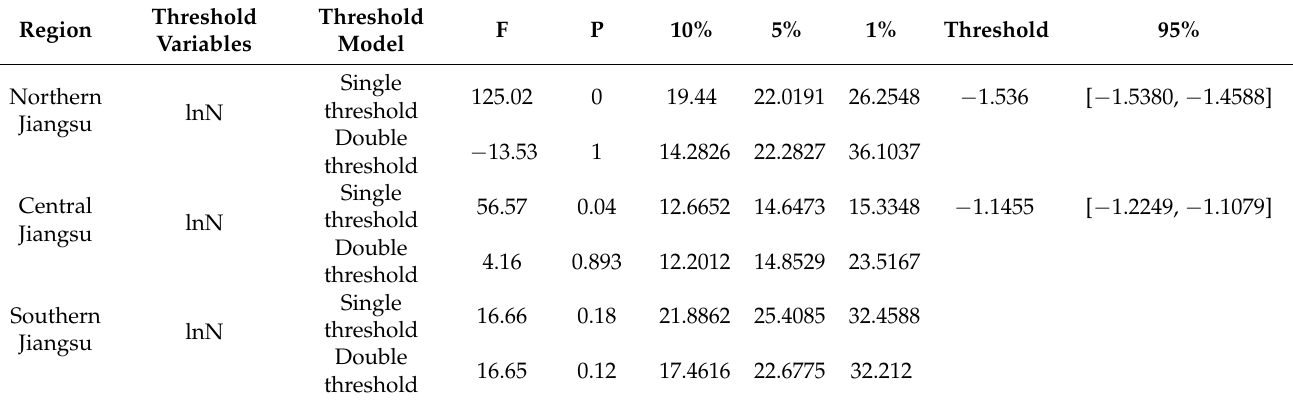
Table 7. Test results of the threshold effect.